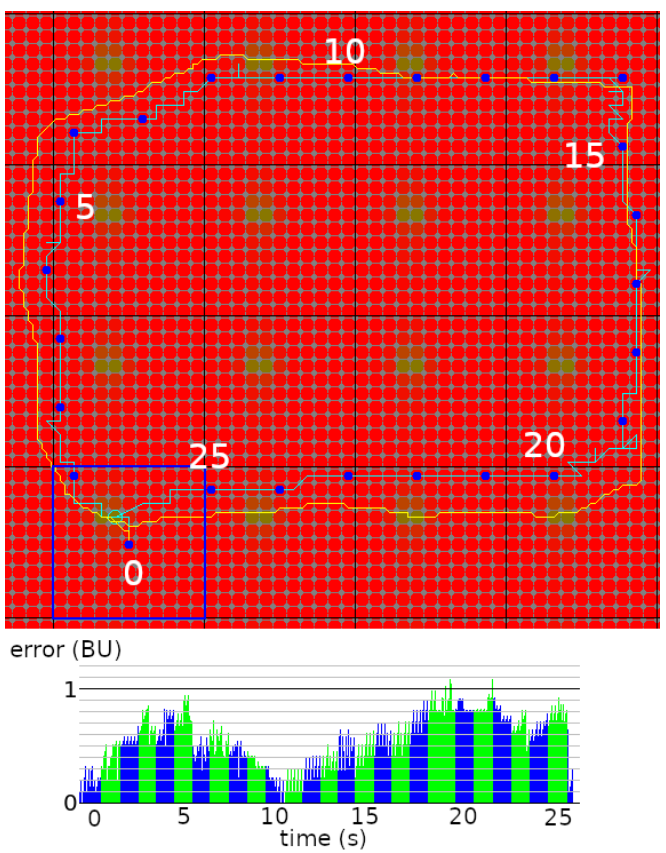
Figure 10. Top : example of tracking when traveling through the main environment loop (Figure 8). Yellow line indicates ground truth, cyan line indicates estimated position. Place cells are represented with blue points, displaying the associated grid cell (note that the grid cell module is repeated). Bottom : estimated position error through time, in Block Unit (BU). Color changes indicate place cell